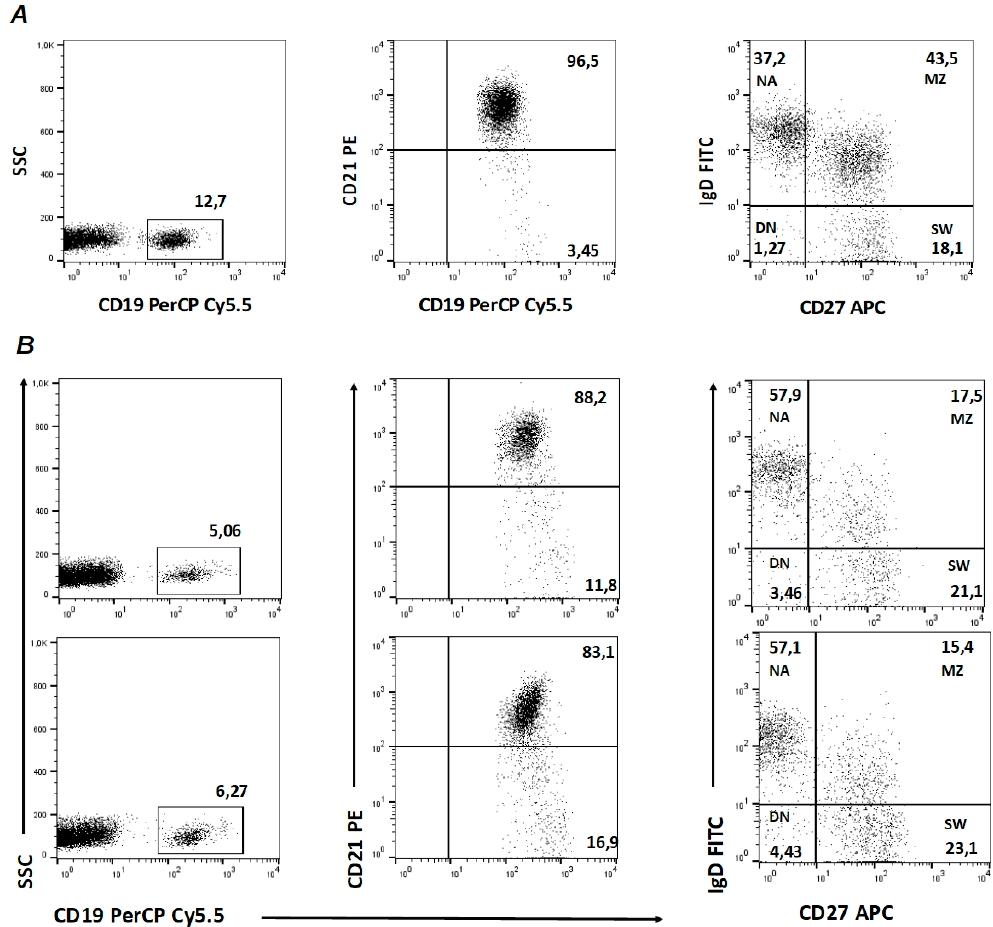
Figure 1. Gating strategy of CD21 low B cells and B-cell subpopulations in ( A ) one healthy control (HC) at t1 and in ( B ) one representative systemic sclerosis (SSc) patient at t1 (upper panel) and at t3 (lower panel). NA: IgD + CD27 − naive B cells; MZ: IgD + CD27 + marginal-zone B cells; SW: IgD − CD27 + switched-memory B cells; DN: IgD − CD27 − double-negative B cells.